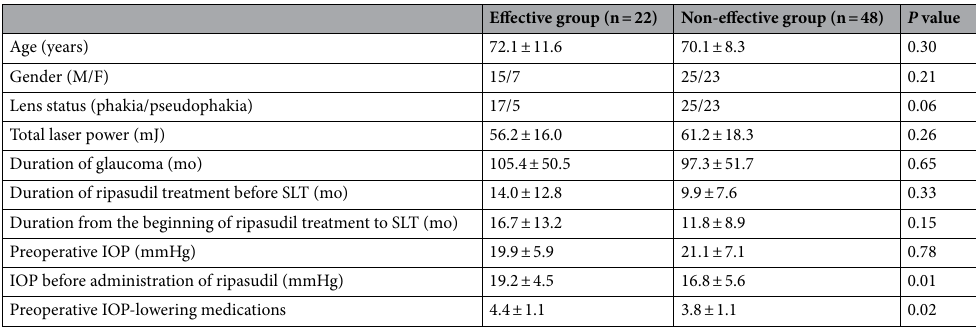
Table 1. Clinical characteristics. M male, F female, SLT selective laser trabeculoplasty, IOP intraocular pressure.